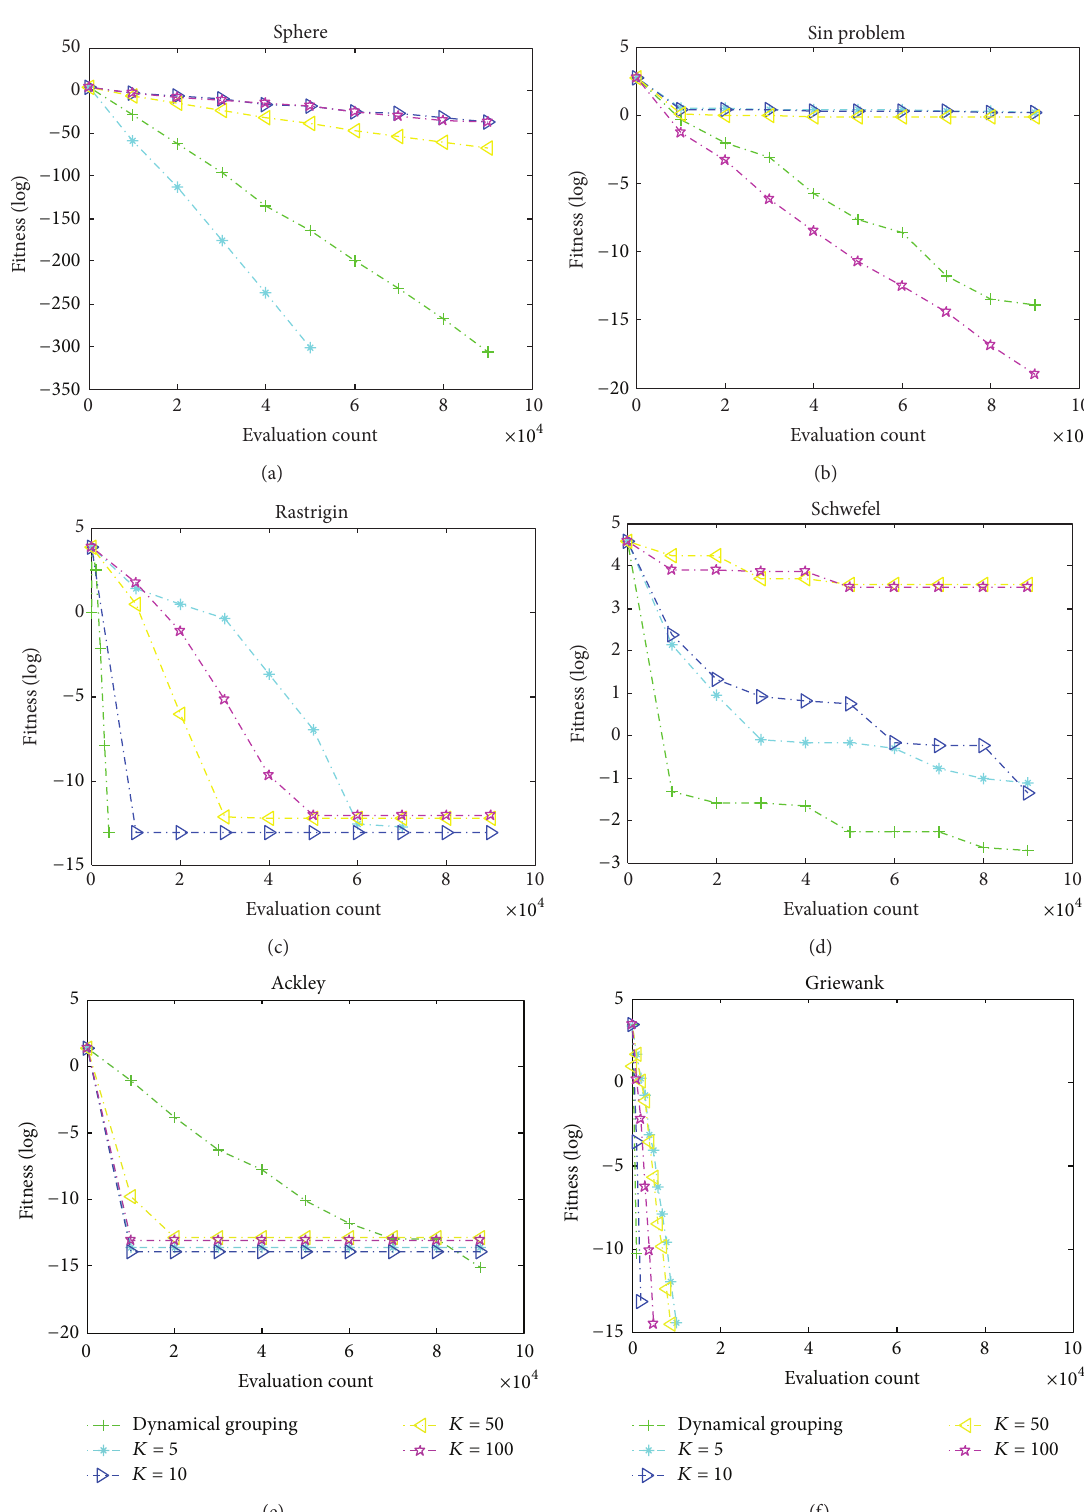
Figure5:Themedianconvergenceresultsof100Dcontinuousfunctions.(a)Spherefunction.(b)Sinproblemfunction.(c)Rastriginfunction. (d) Schwefel function. (e) Ackley function. (f) Griewank